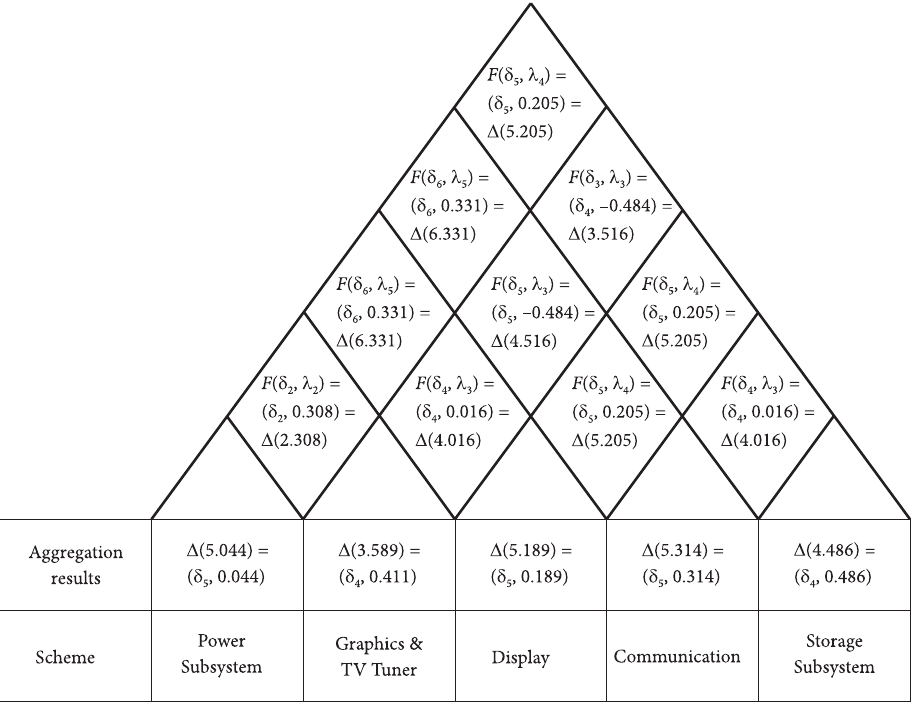
Fig. 6. Aggregation results for the correlation matrix with the order of priority